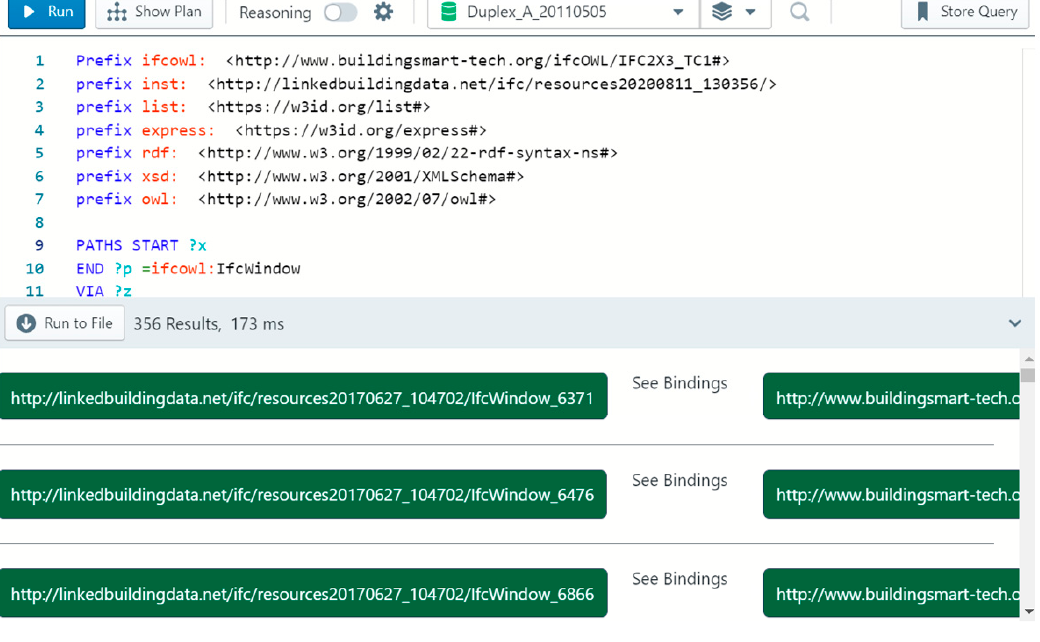
Figure 5. The results of Stardog path query of the keyword